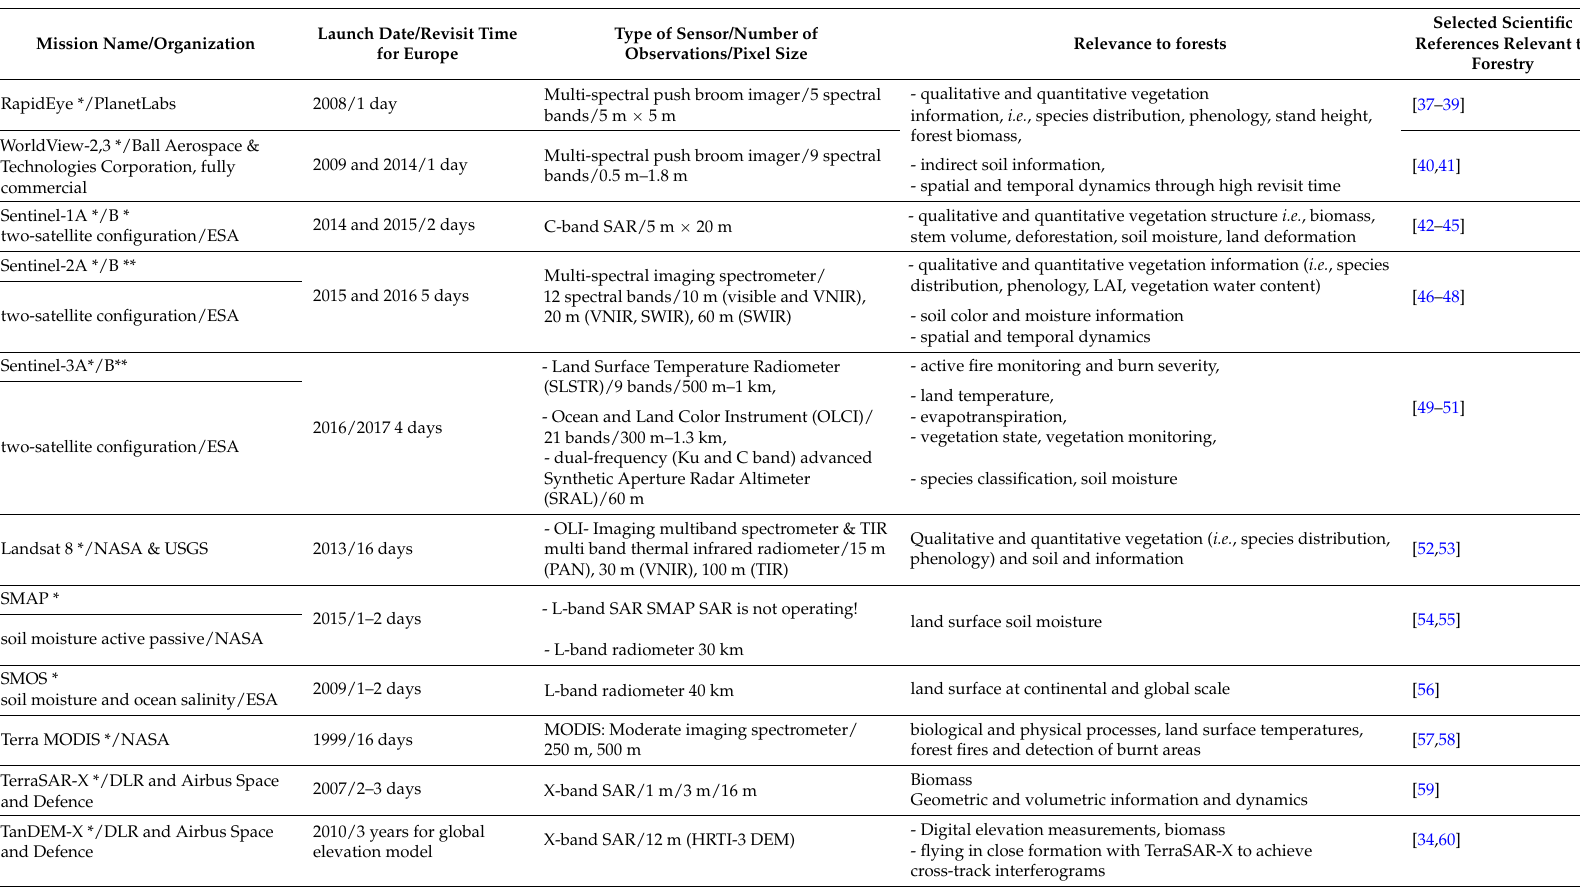
Table 3. Summary of recent satellite remote-sensing missions. * missions under development; ** missions under study or proposal phase; *** relevant to the assessment of forest